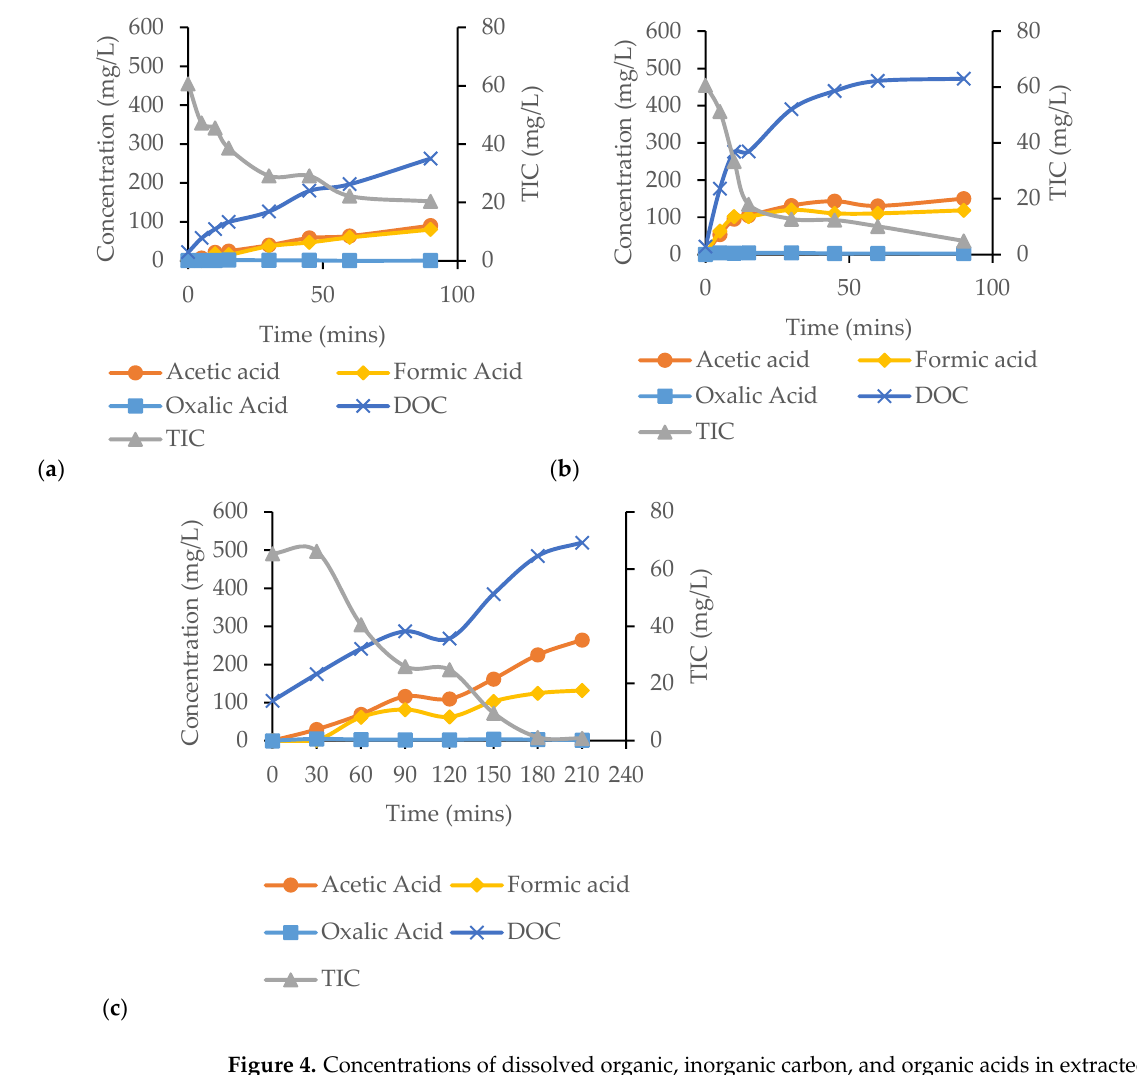
Figure 4. Concentrations of dissolved organic, inorganic carbon, and organic acids in extracted water after oxidation with ( a ) WAO (90 min), ( b ) WAPO (90 min), and ( c ) WAO extended (210 min); 90 min = 3 × 30 min cycles, and 210 min = 7 × 30 min cycles.